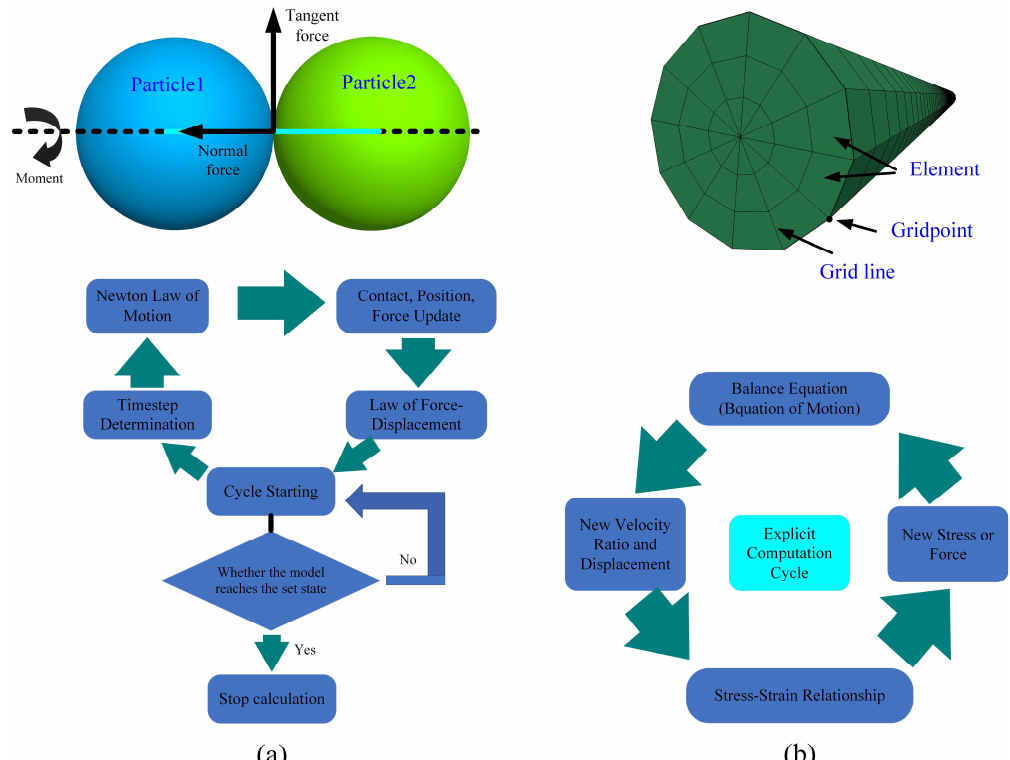
Figure 3. The basic principles and calculation processes of simulation software: ( a ) PFC software; ( b ) FLAC software.